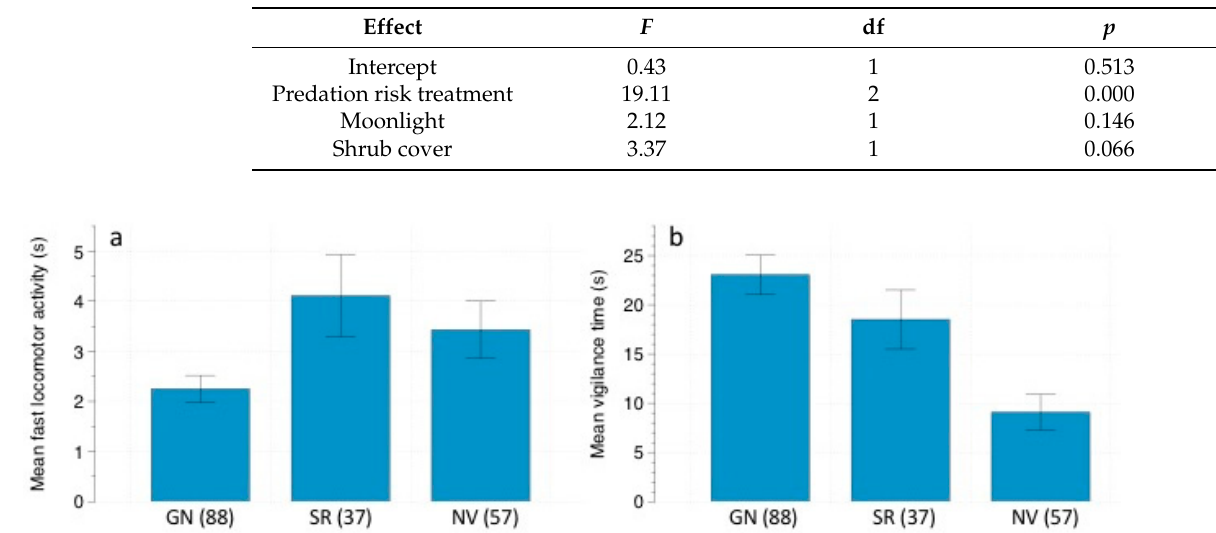
Table 6. Results of the GLM analyzing the effect of experimental and environmental factors on O. longicaudatus fast locomotor activity.